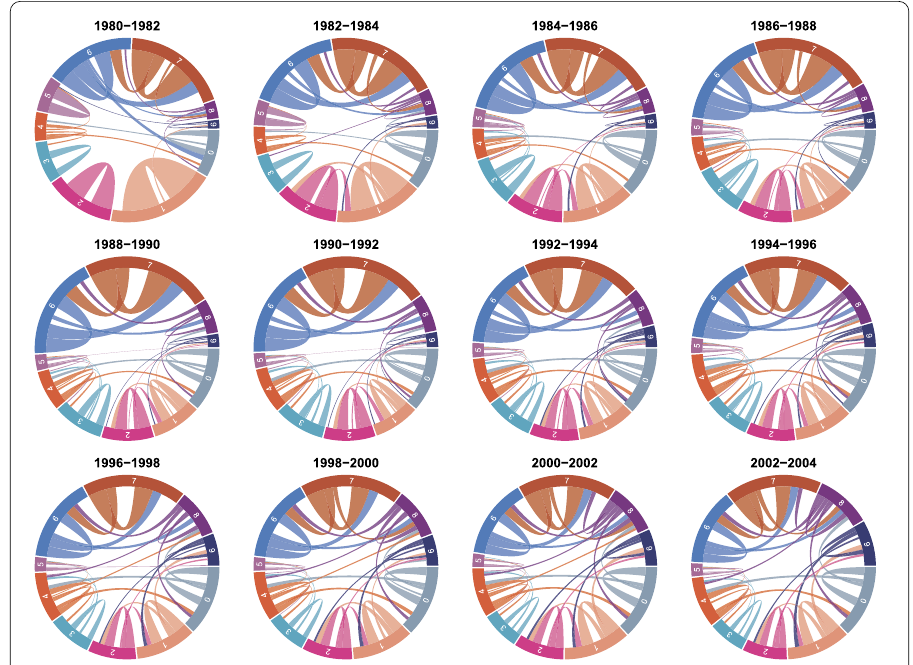
Figure 8 Authors flow across fields against null model. For each time window (2 years), PACS are disposed in a circle. The width of each arc is proportional to the number of authors who published at least one paper in that field (and that published at least another one the year after). Each field is represented by its PACS number, see Table 1. Links represent the number of authors who, having published at least one paper in the source field on the right, also publish at least one paper in the target field on the left (at seen from outside the circle). Only significative links are considered—i.e. links with a Z-score equal or larger than 2 with respect to a null model where links are reshuffled preserving nodes degree and strength. Note that an author can publish papers in several fields in a given time window so that a link does not mean that she changed her field